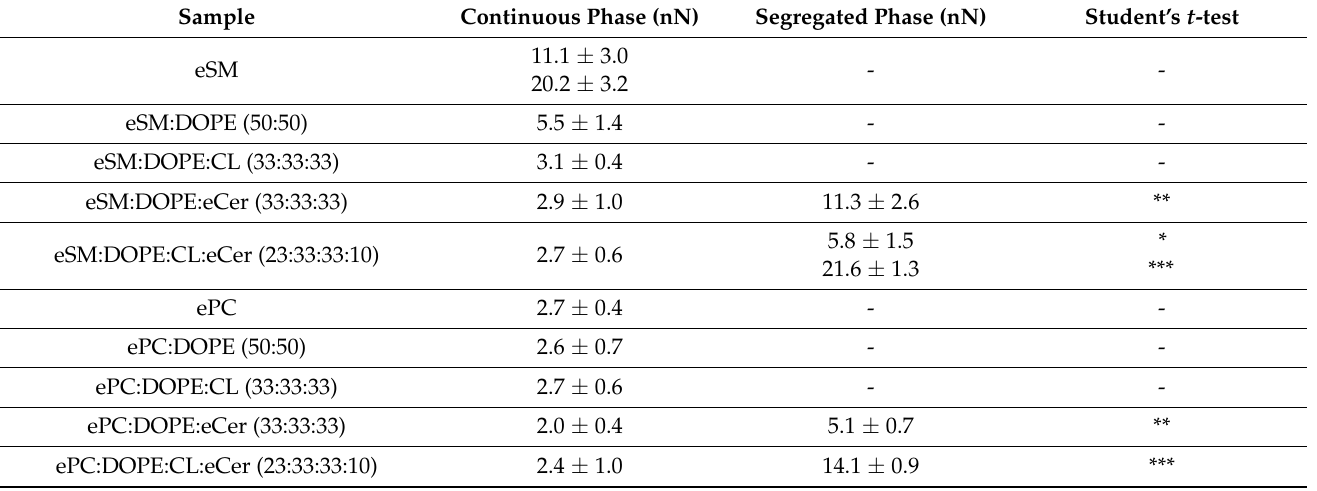
Table 3. Bilayer nanomechanical resistance of the different SLB under study. Data expressed as mean ± SD, n = 150–800. Significance, according to Student’s t -test: * p < 0.05; ** p < 0.01; *** p <